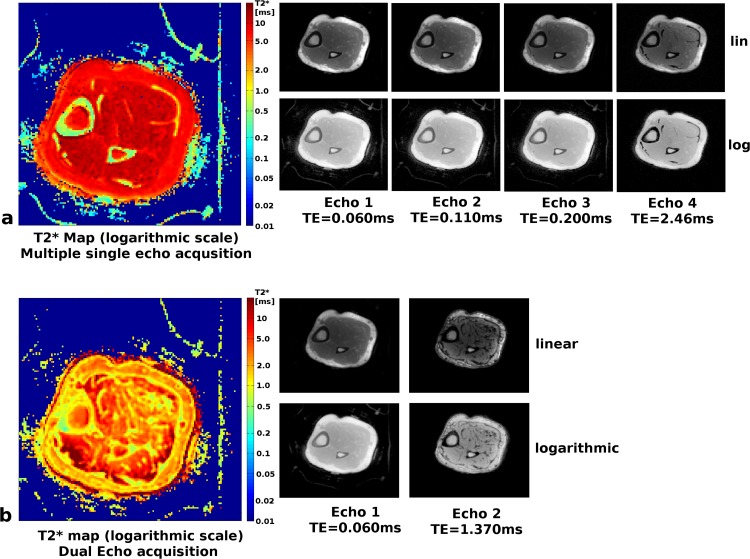
UTE images and T2* maps of the tibial cortical bone: (a) Single echo sequence with individual acquisitions of different echo times (TR = 6 ms). The individual images at each echo time are shown with linear scaling of the gray values in the top row and with logarithmic scaling in the bottom row. The T2* map on the left is also displayed with a logarithmic color scale in units of ms. (b) Single run of the dual echo sequence with the shortest possible second echo time TE = 1370 μs and TR = 4 ms. The top row shows linearly and the bottom row logarithmically scaled gray values. The T2* map on the left is again displayed with a logarithmic color scale.